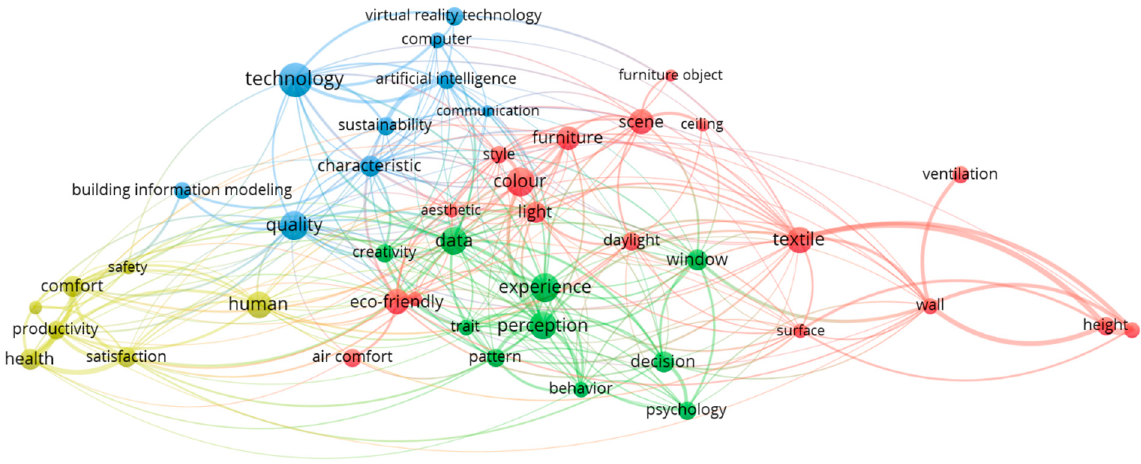
Figure 5. Network analysis results of co-occurrence of keywords and abstracts.